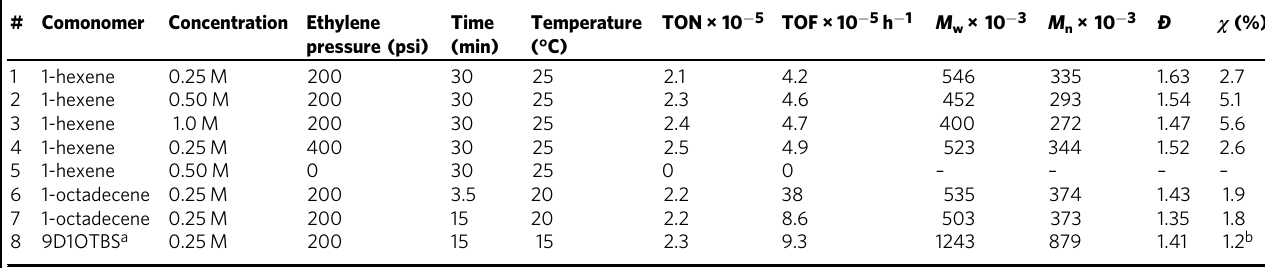
6 1-octadecene 0.25 M